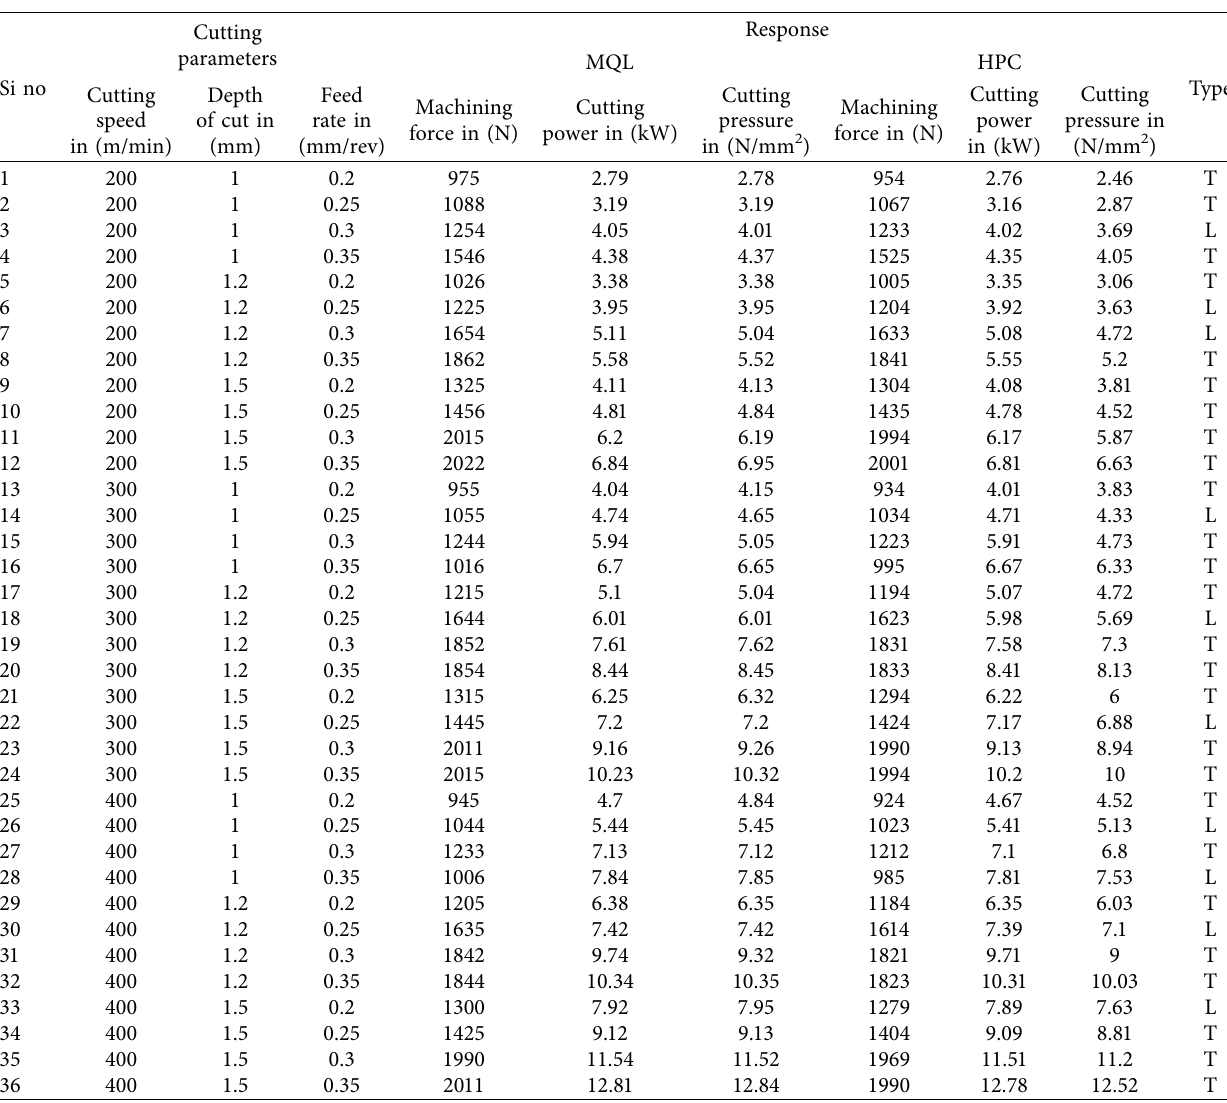
Table 1: Cutting parameters and